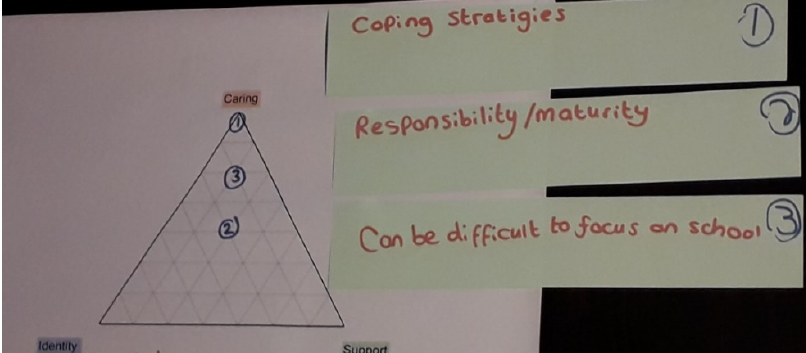
Figure 3. Thea struggled to balance caring with school and found that her extra responsibilities affected her school focus (Impact 3).